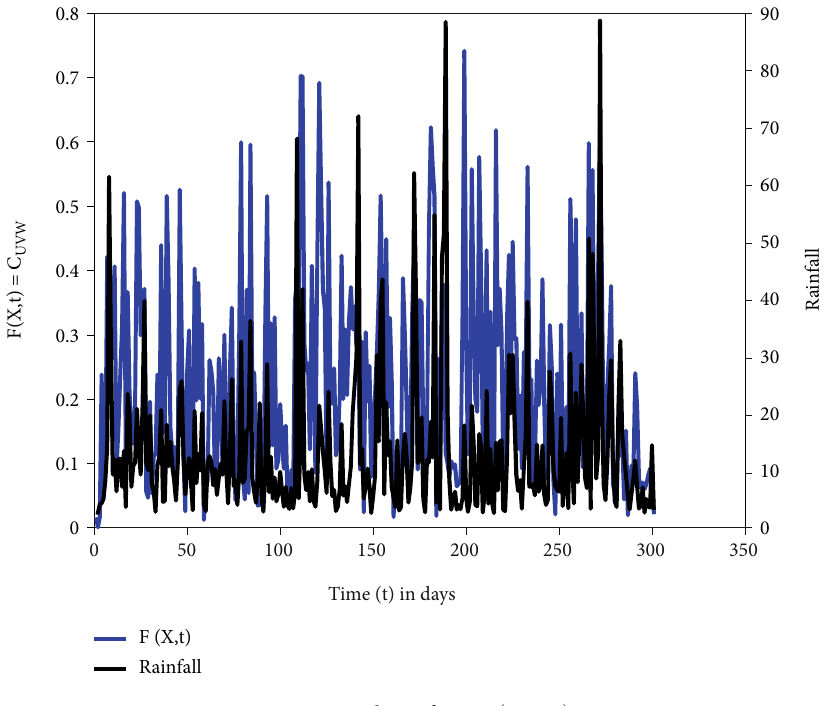
Figure 7: Values of C